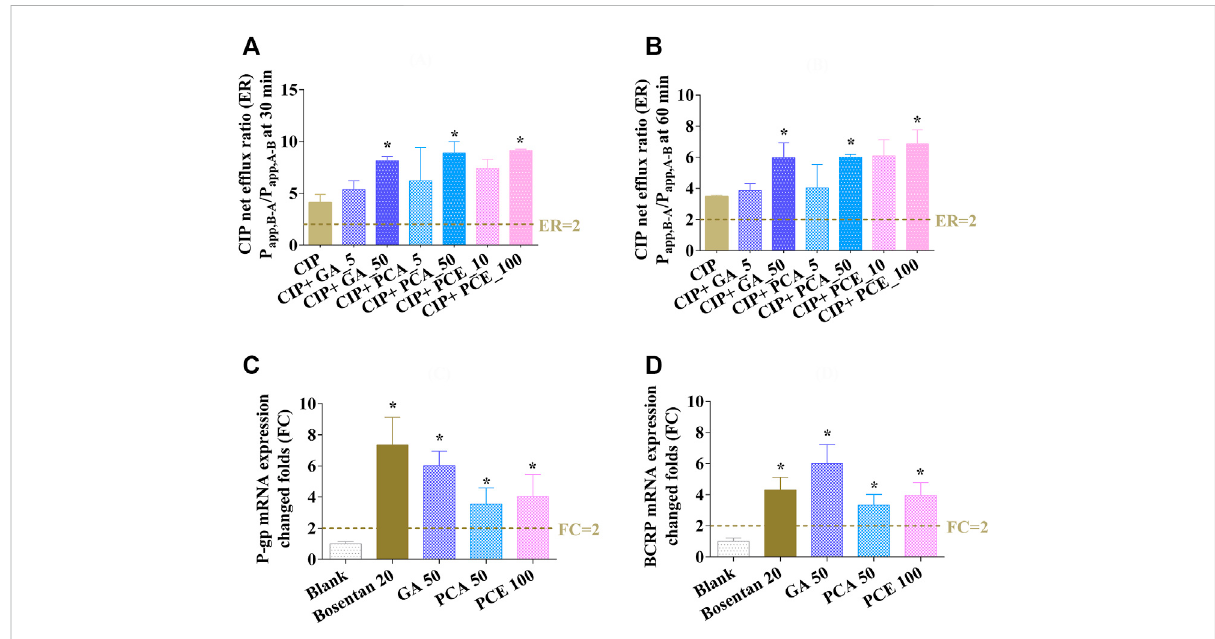
FIGURE 10 Effects of gallic acid (GA), protocatechuic acid (PCA) and PCE on the change of cipro fl oxacin ef fl ux ratios at 0.5 h (A) and 1 h (B) , and themRNA expressions of MDR1 (C) and BCRP (D) in Caco-2 cells (mean ± SD, n =